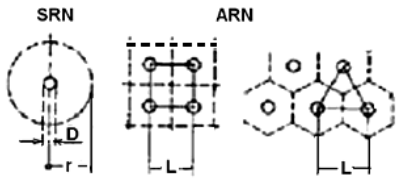
Fig. 3. Positions of round holes in the sprayer used for intensive quenching of large steel part